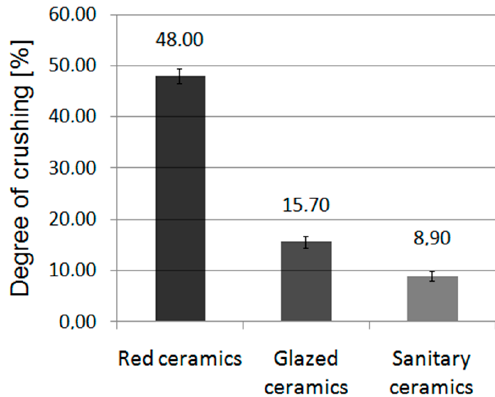
Figure 7. Degree of crushing of the tested ceramics (error bars mean standard deviations of degree of crushing).